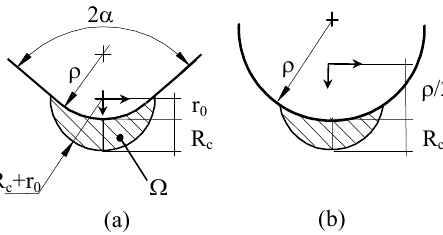
Figure 4: Critical volume for (a) V-shaped notches and (b) semicircular